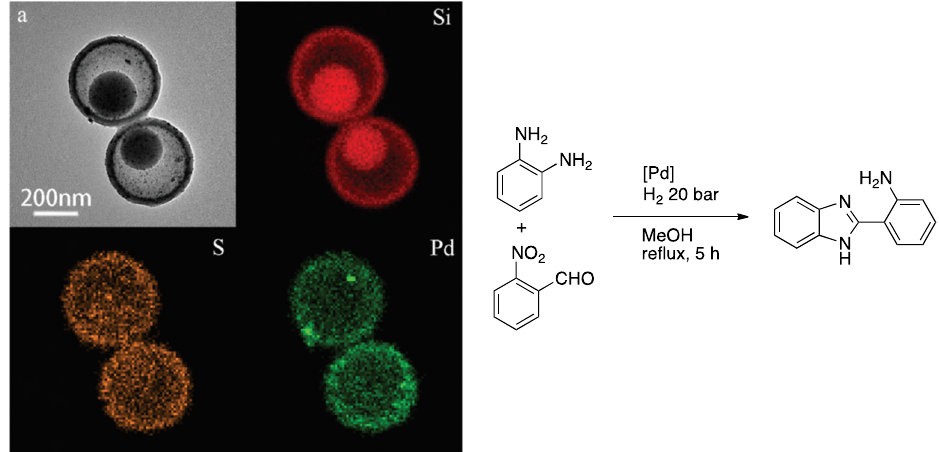
Scheme 19. Left: TEM image (a) and elemental mapping (TEM coupled to EDS